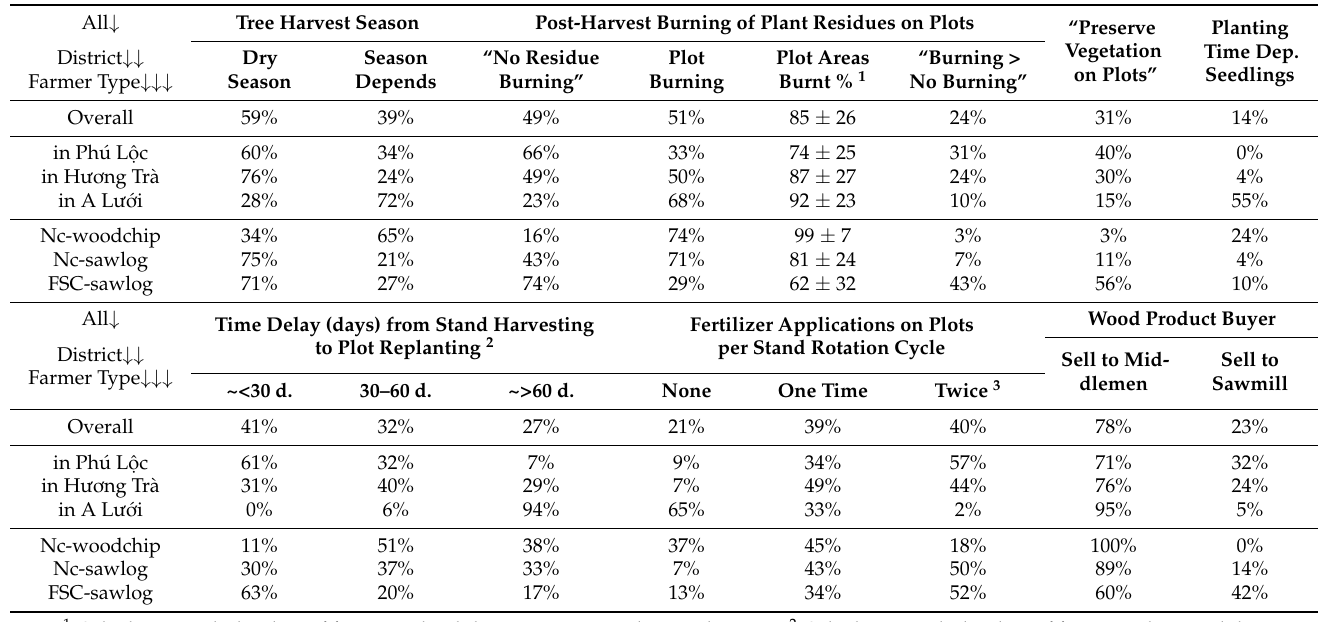
Table 6. Summary of data on acacia tree harvesting and replanting times, post-harvest plot management practices, and product selling, showing differences among the three study districts and farmer